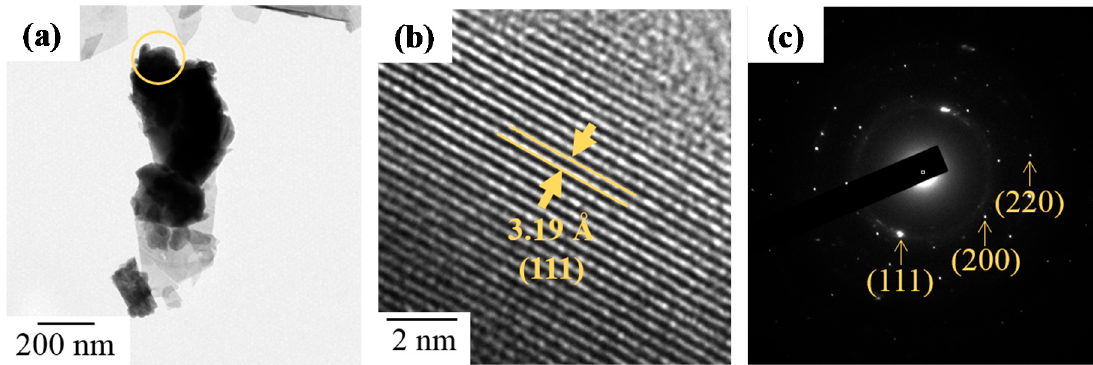
Figure 10. ( a , b ) TEM images and ( c ) SAED pattern of Bi 1.0 Zr 1.0 O 3.5 powders after heat treatment at 750 °C.